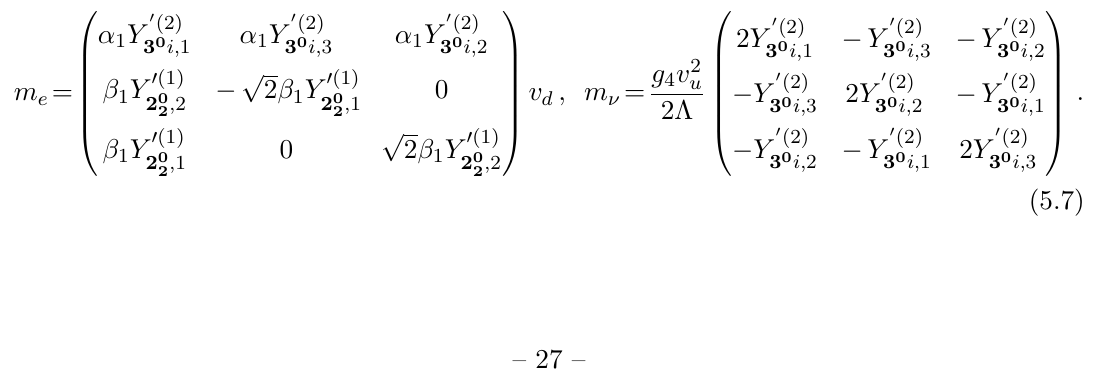
table 8 for a summary of level 6 modular forms and the decomposition under T 0 . As